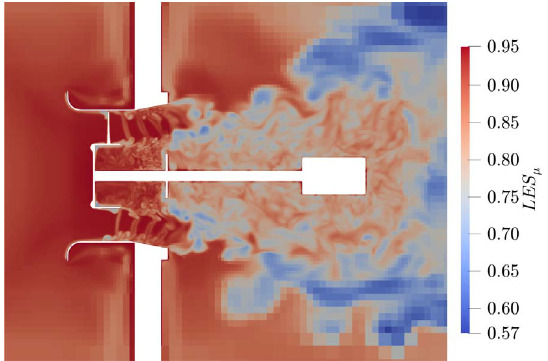
Figure 13. Resolution of the DES simulation with values above 0.8 show a recommended resolution after